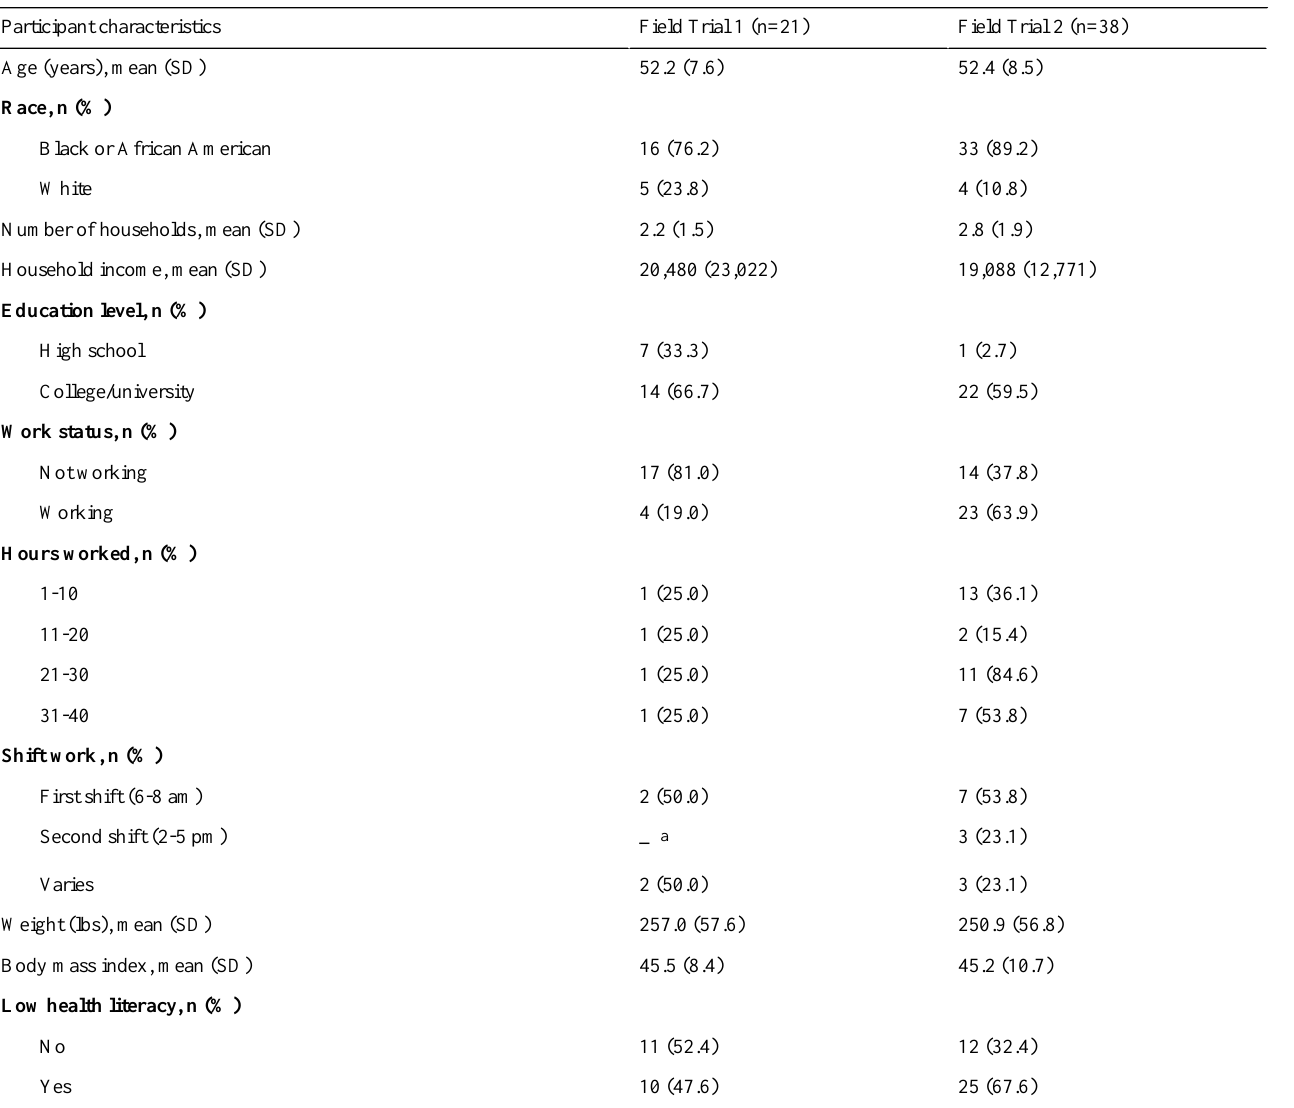
Table 3. Descriptive statistics for participants in field trials 1 and